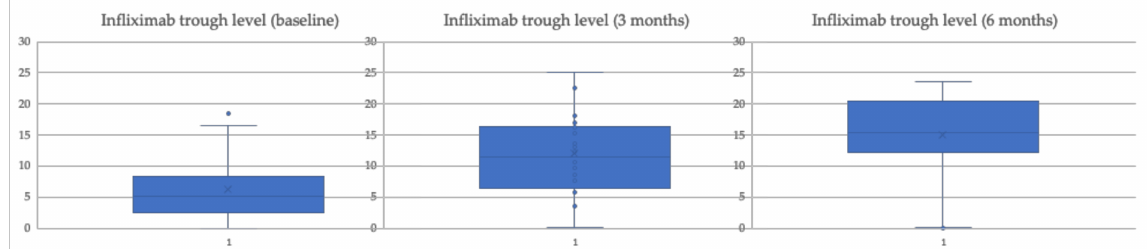
Figure 1. Trends in serum infliximab concentrations ( µ g/dL) standard dose patients.